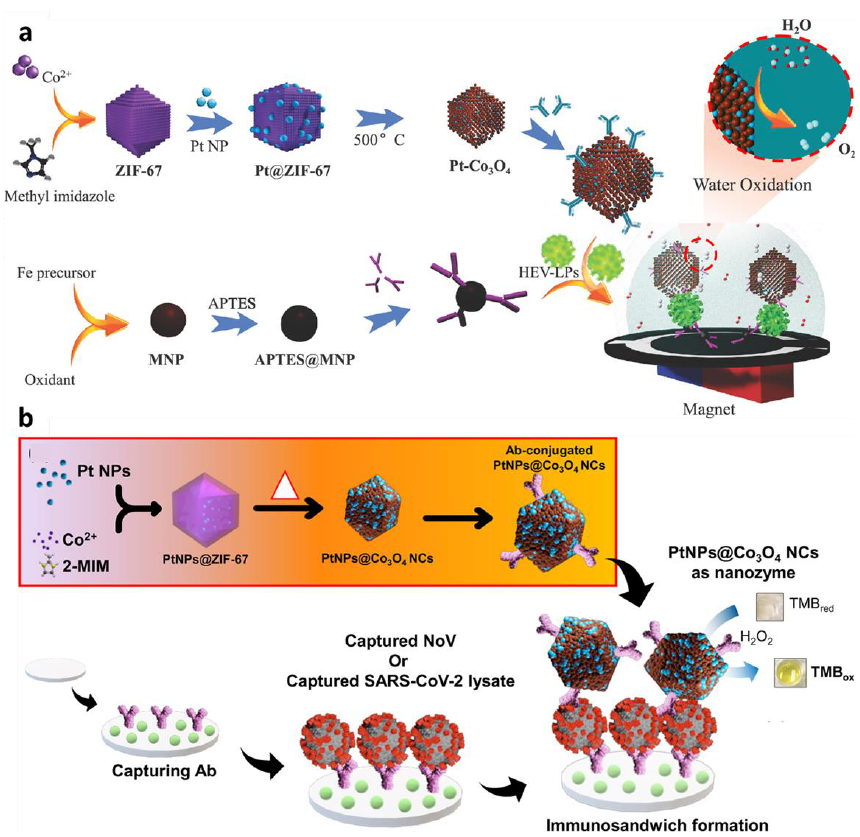
Figure 9. Schematic illustration of MOF-based signal amplification on nanobiosensor for virus detection. ( a ) Illustration of the fabrication process of PtNP − incorporated ZIF-67 nanostructure for hepatitis E virus (HEV) detection by electrocatalytic water oxidation. Adapted with permission from [85] . Copyright 2020, American Chemical Society. ( b ) Illustration of the fabrication process of PtNP-embodied ZIF − 67 nanostructure encapsulating chromogen (TMB) for SARS-CoV-2 detection immunoassay. Adapted with permission from [86] . Copyright 2022, Elsevier.